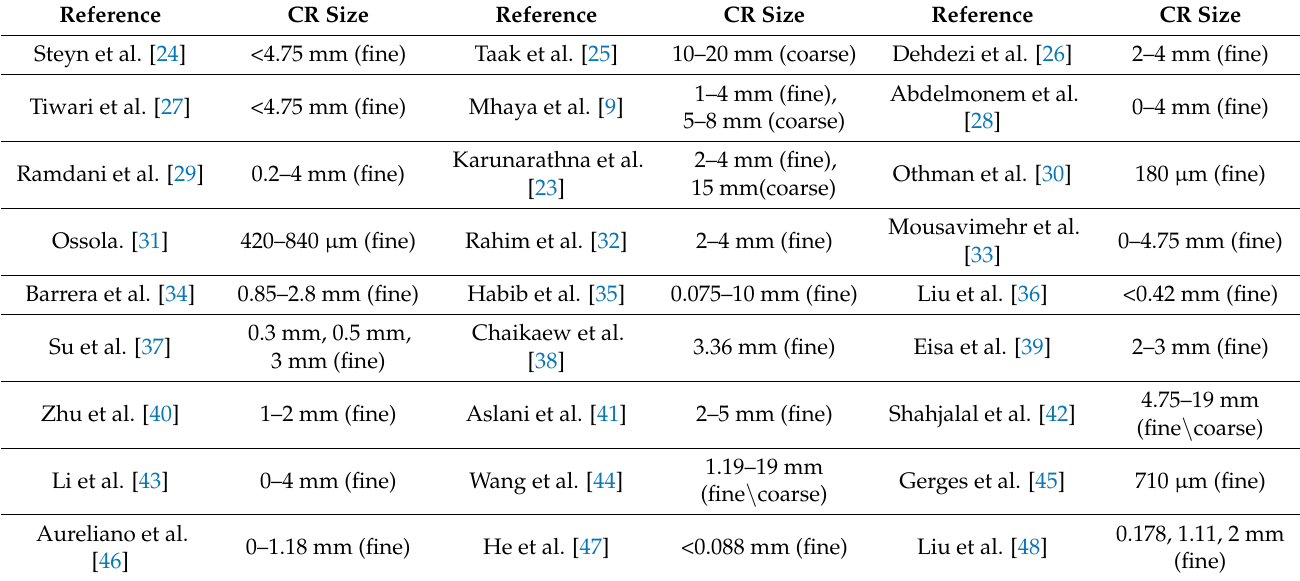
Table 2. Rubber particle size statistics table.